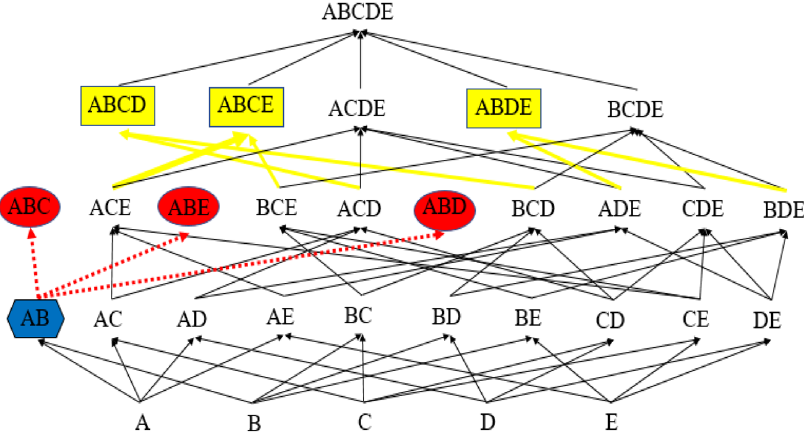
Figure 2. A pruned power set lattice. FD_Mine deletes the candidates ABC , ABE , and ABD (red ovals) as a result of finding the candidate key AB (blue hexagon). It generates supersets of AB (yellow rectangles) at the next level.